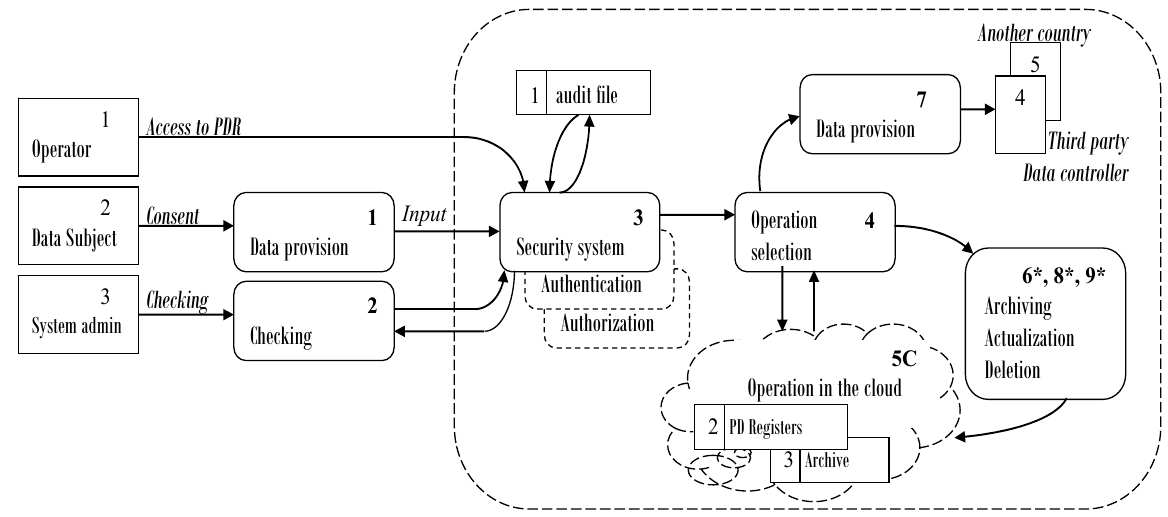
Figure 2. Modified DFD presenting the processing of personal data in the cloud.